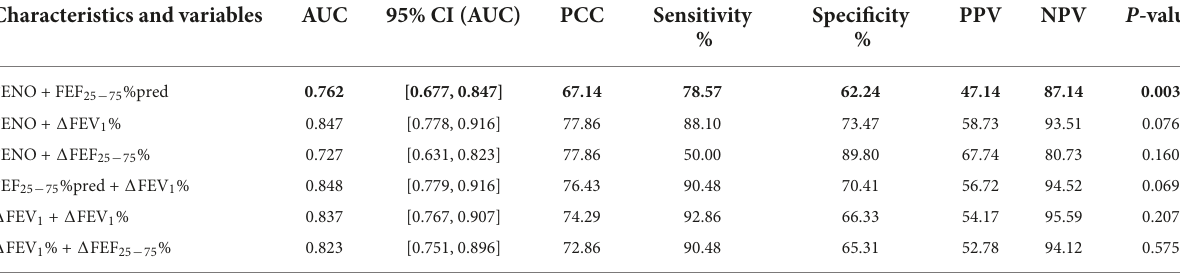
TABLE 3 Predictive values of the different joint models for the prediction of CVA positive diagnosis. Characteristics and variables AUC 95% CI (AUC) PCC Sensitivity